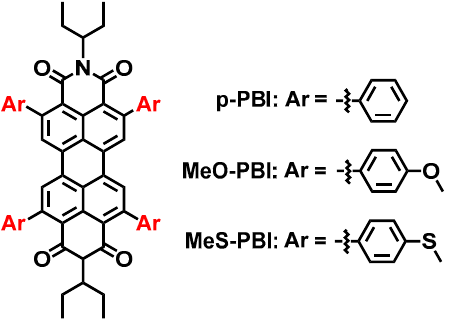
Figure 24. Heavy atom-free PBI derivatives showing